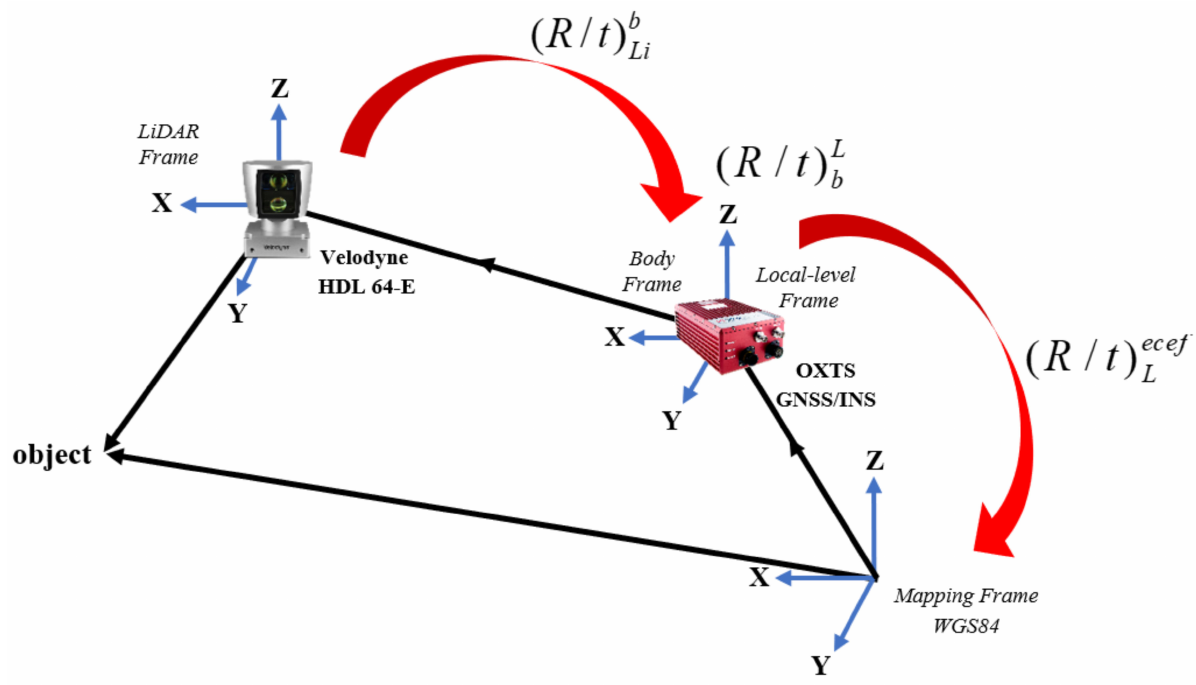
Figure 1. Graphical illustration of LiDAR SLAM pose transformation into the WGS84 reference